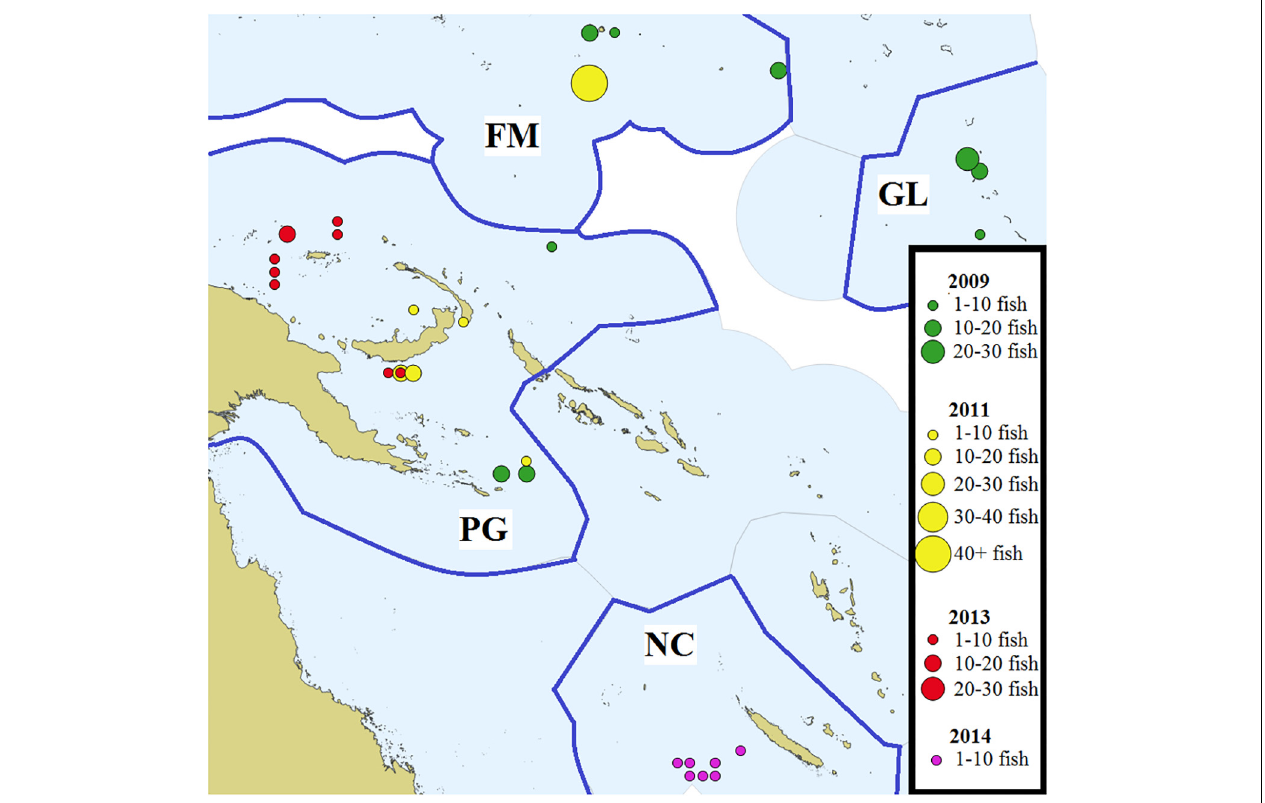
FIGURE 1 | Locations of catch event by year (green = 2009, yellow = 2011, red = 2013, purple = 2014) across the western and central Pacific. Number of fish caught per event is reflected in marker